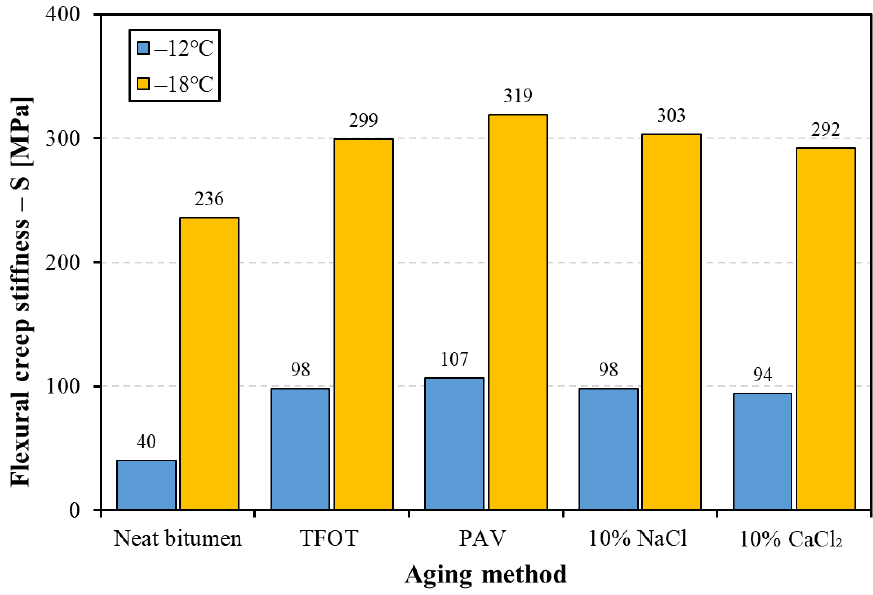
Figure 6. The flexural creep stiffness of bitumen before and after aging.